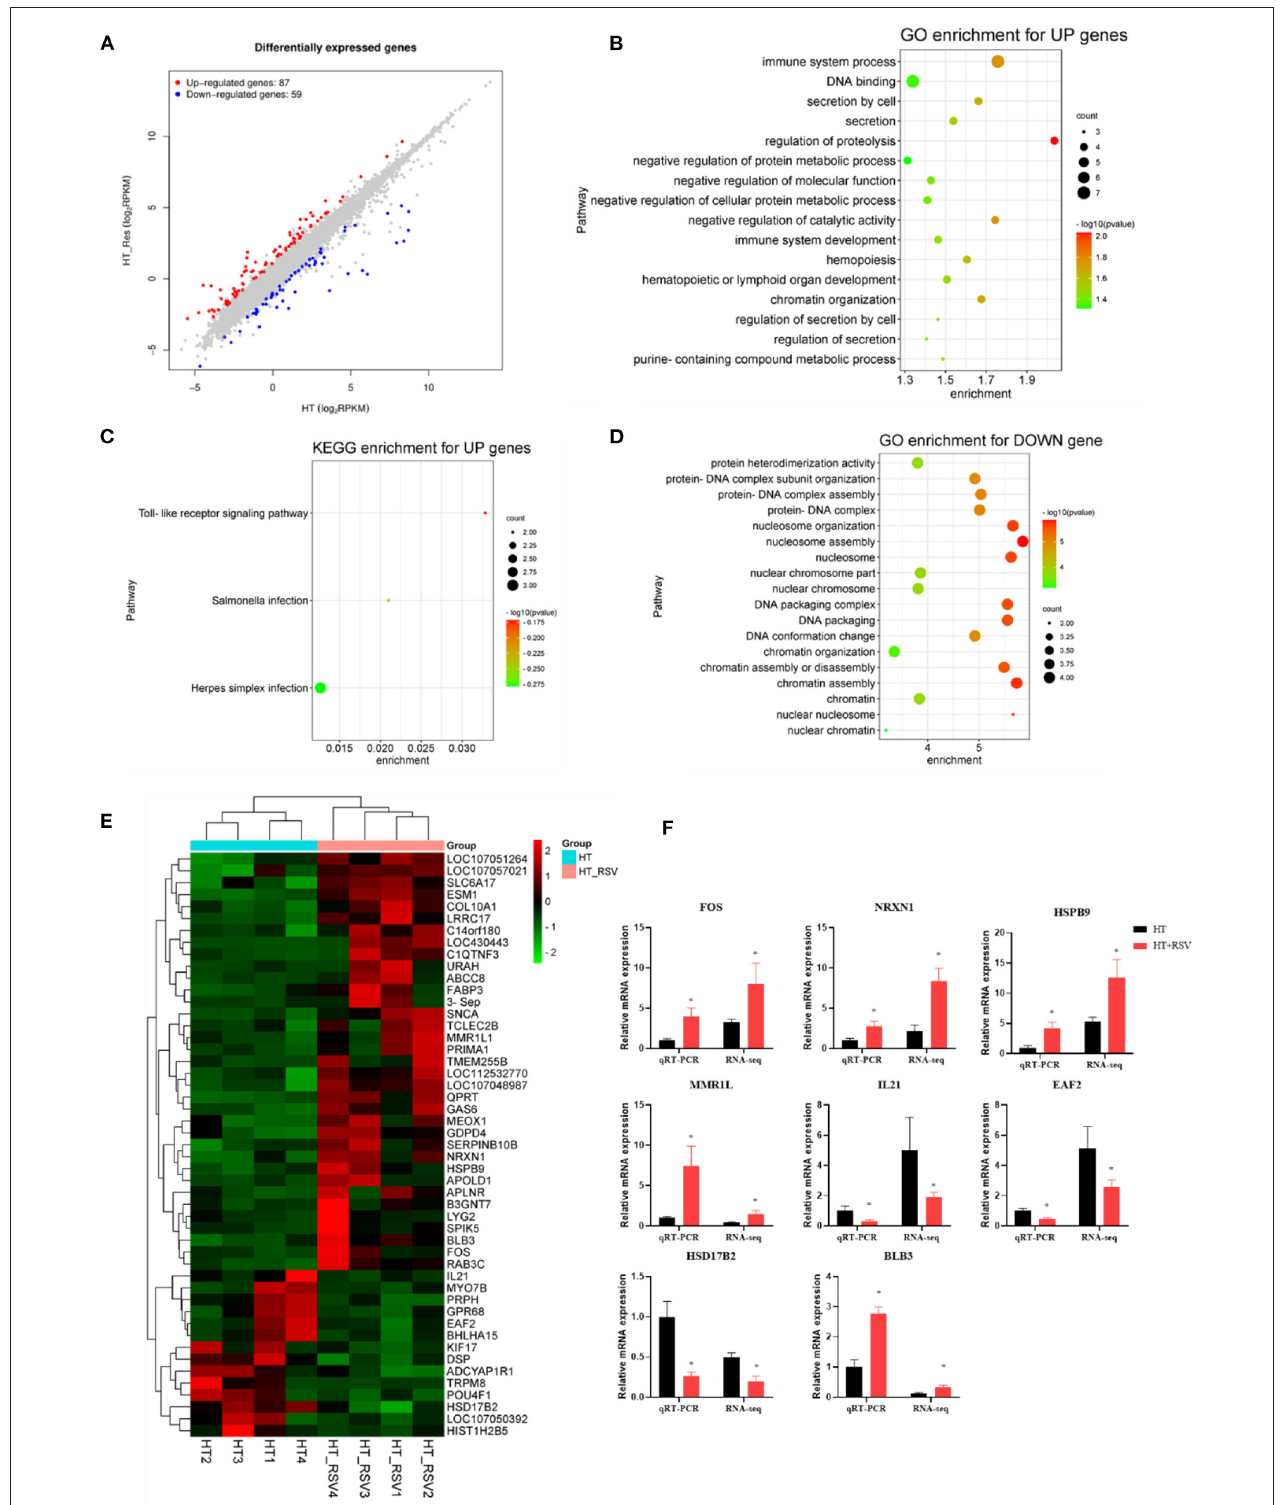
FIGURE 5 | Effects of heat stress and RSV on the splenic transcriptome of 42-day-old broilers (d 14 of heat treatment). (A) Numbers of RSV-induced differentially expressed splenic genes ( P < 0.05 and fold change ≥ 2; n = 4). (B) GO terms enrichment of splenic gene expression for up genes in broilers ( P < 0.05). (C) KEGG terms enrichment of splenic gene expression for up genes n broilers ( P < 0.05). (D) GO terms enrichment of splenic gene expression for down genes in broilers ( P < 0.05). (E) The heat map of DEG genes in broilers. (F) Validation of the gene expression profile by real-time PCR. Asterisk means significant difference with HT group (* P < 0.05). RSV, resveratrol; HT, heat stress.